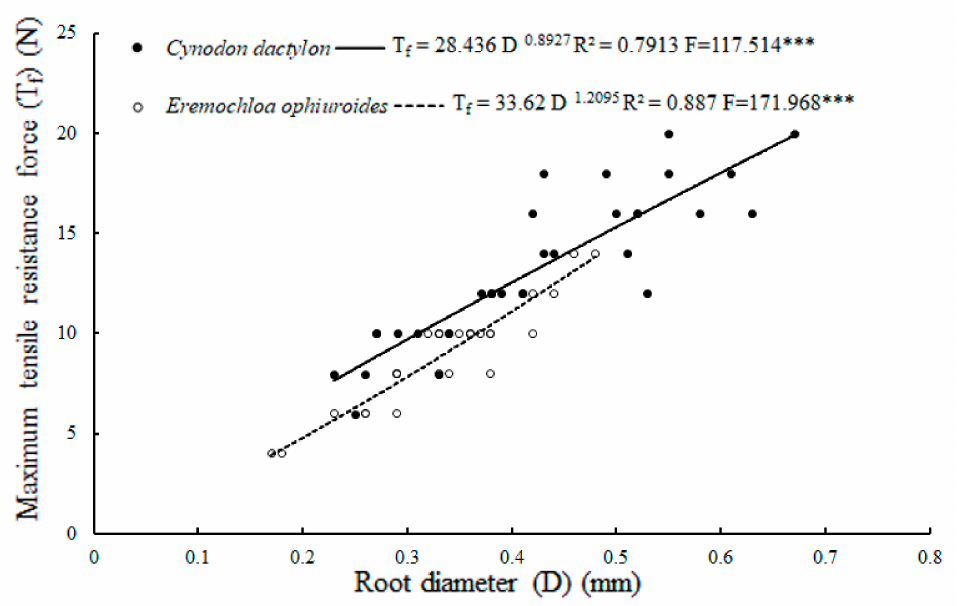
Figure 4. Relationship between root tensile resistance and root diameter for C. dactylon and E. ophiuroides . Level of significance: *** p <